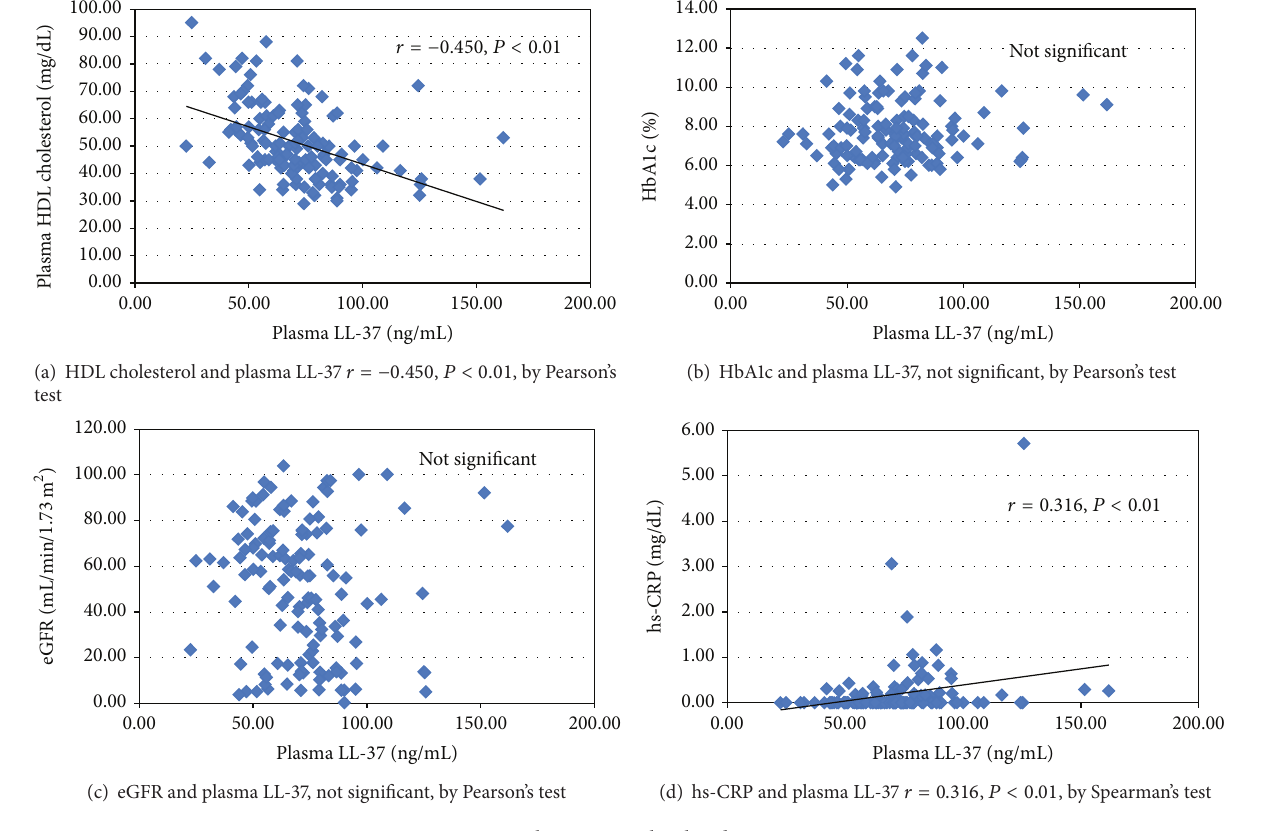
Figure 2: Plasma LL-37 level and covariates.